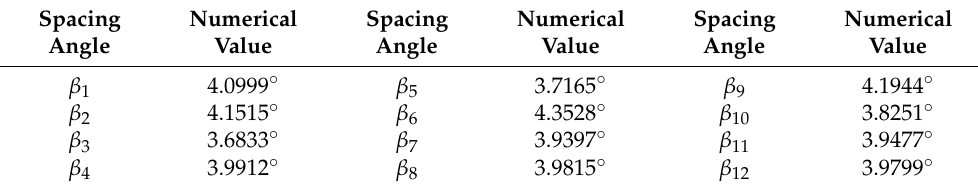
Table 2. Electrode spacing angle parameter of heterogeneous ECT sensor.